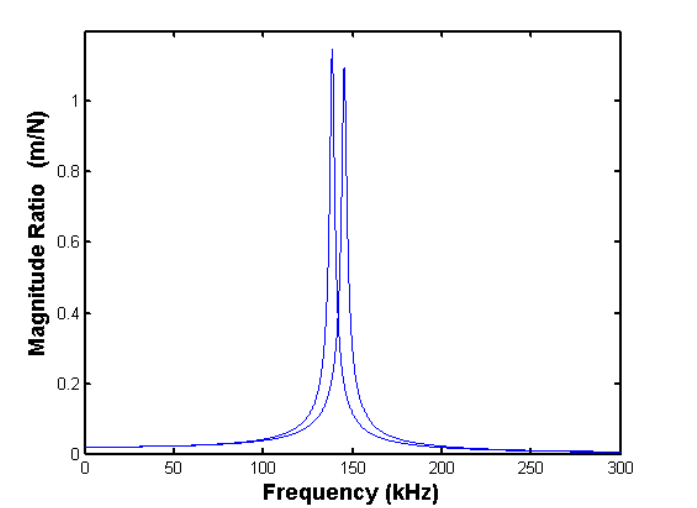
Figure 13. Effect of 10% mass change on frequency